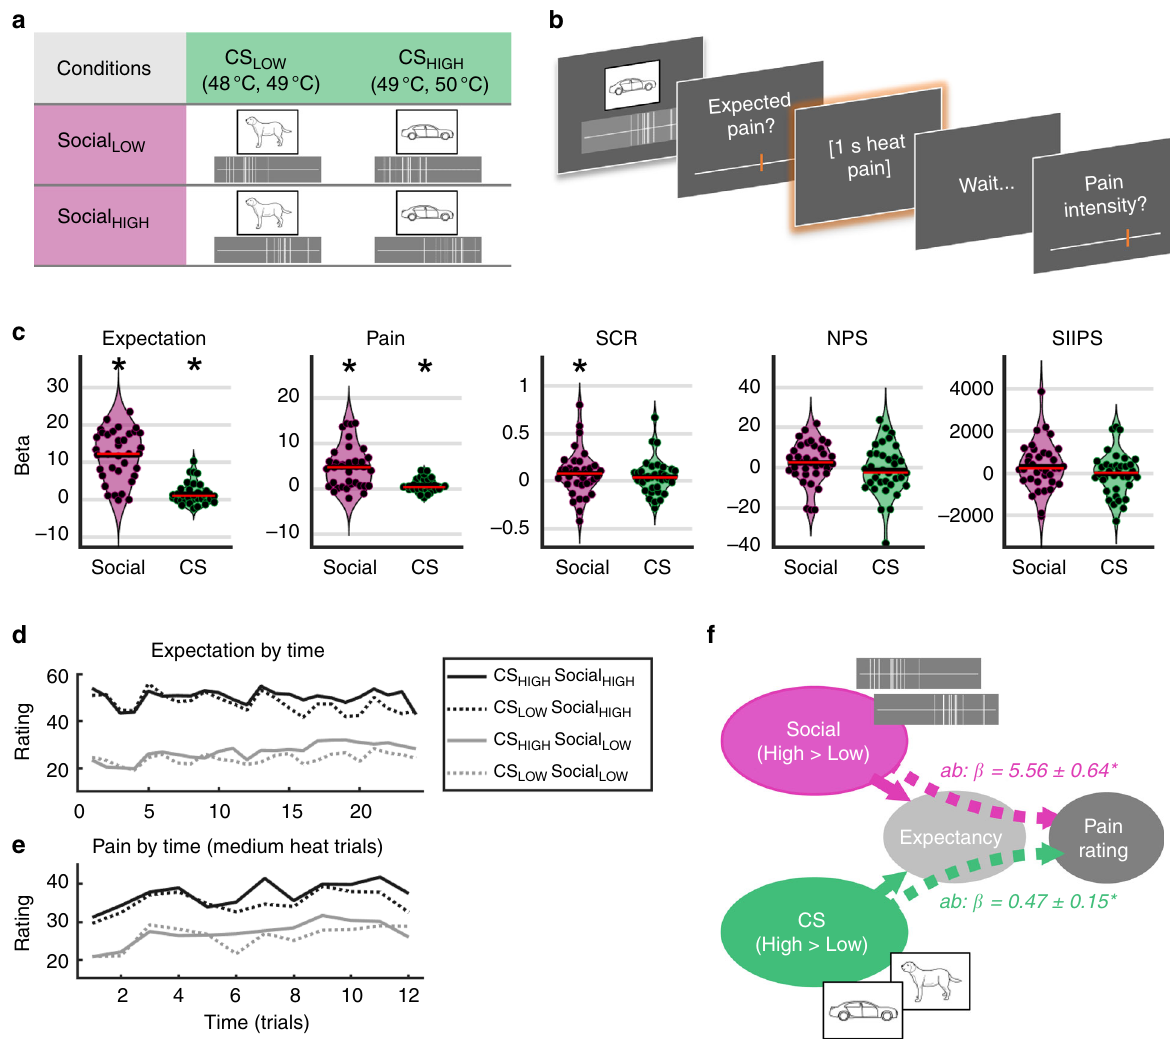
Fig. 1 Design and results. a Design. The social information could be either low or high on average (Social LOW or Social HIGH ), but was not correlated with actual heat intensity. In contrast, the learning cues (CS LOW and CS HIGH ,) were followed by low-to-medium or medium-to-high heat intensity, respectively. b Each trial started with the simultaneous presentation of social information ( “ pain ratings of previous participants ” , depicted as vertical lines on a VAS) and one of the CS (animal or vehicle drawing). Participants then rated their pain expectation, received a short heat pain stimulation, and rated how much pain they experienced. c Effects on behavior, physiology, and brain patterns. Violinplots show the effects for Social HIGH > Social LOW and CS HIGH > CS LOW . Each dot re fl ects the beta (effect magnitude) estimate of one participant. Both social information and CS signi fi cantly in fl uenced expectation (social information: t (35) = 10.65, p < 0.001, CS: t (35) = 3.02, p = 0.005) and pain ratings (social: t (35) = 6.19, p < 0.001, CS : t (35) = 3.13, p = 0.003). Skin conductance responses (SCR) were signi fi cantly modulated by social information ( t (35) = 2.04, p = 0.049), but not by CS. Neither NPS nor SIIPS showed signi fi cant responses to social information or CS. Asterisks denote signi fi cant effects at p < 0.05 (using t tests). d , e Time course of expectation and pain ratings. The difference between dotted and solid lines re fl ects the CS effect, and the difference between gray and black lines the social information effect. CS effects on expectation and pain increased over time (interaction effects CS*Time on expectation: t (35) = 3.02, p = 0.004, on pain: t (35) = 2.03, p = 0.049). Social information effects on expectations and pain remained signi fi cant throughout the experiment, but decreased over time for expectation ratings (Social × Time on expectations: t (35) = − 4.57, p < 0.001). The x -axis shows trials per condition. f Behavioral mediation analysis. Expectation ratings signi fi cantly mediated both Social ( t (35) = 8.56, p < 0.001) and CS effects on pain ( t (35) = 3.27, p < 0.001). Source data for panels c , d , and e are provided as a Source Data fi